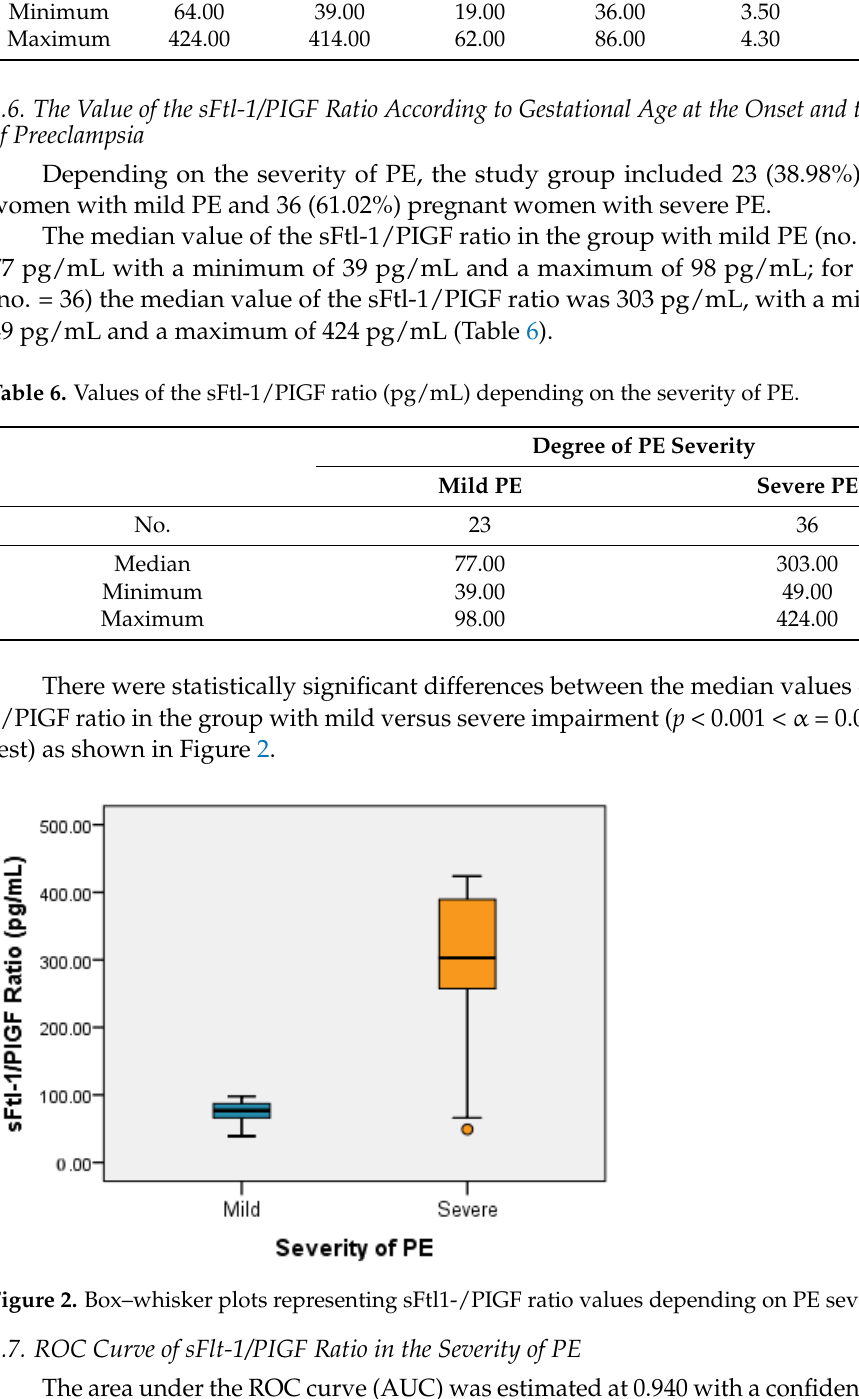
Figure 3. ROC curve of sFtl-1/PIGF ratio in mild versus severe PE. 3.8. The Value of the sFtl-1/PIGF Ratio According to Gestational Age at Onset and Severity of Preeclampsia The values of sFtl-1/PIGF according to the severity and onset of PE are represented in Table 7 and Figure 4.